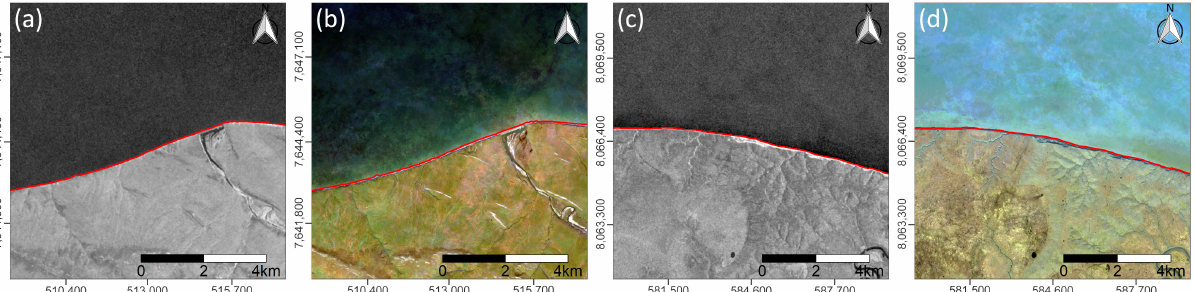
Figure 6. Subsections of the two regions of interest, Corwin Bluffs in the USA (aoi 01) ( a , b ) and Bezimyanniy Cape in Russia (aoi 09) ( c , d ). Median images (months June–September) for the year 2020 from S1 in VV polarization ( a , c ) and Sentinel-2 (S2) in RGB ( b , d ) are shown together with the manually digitized reference coastline (red line).